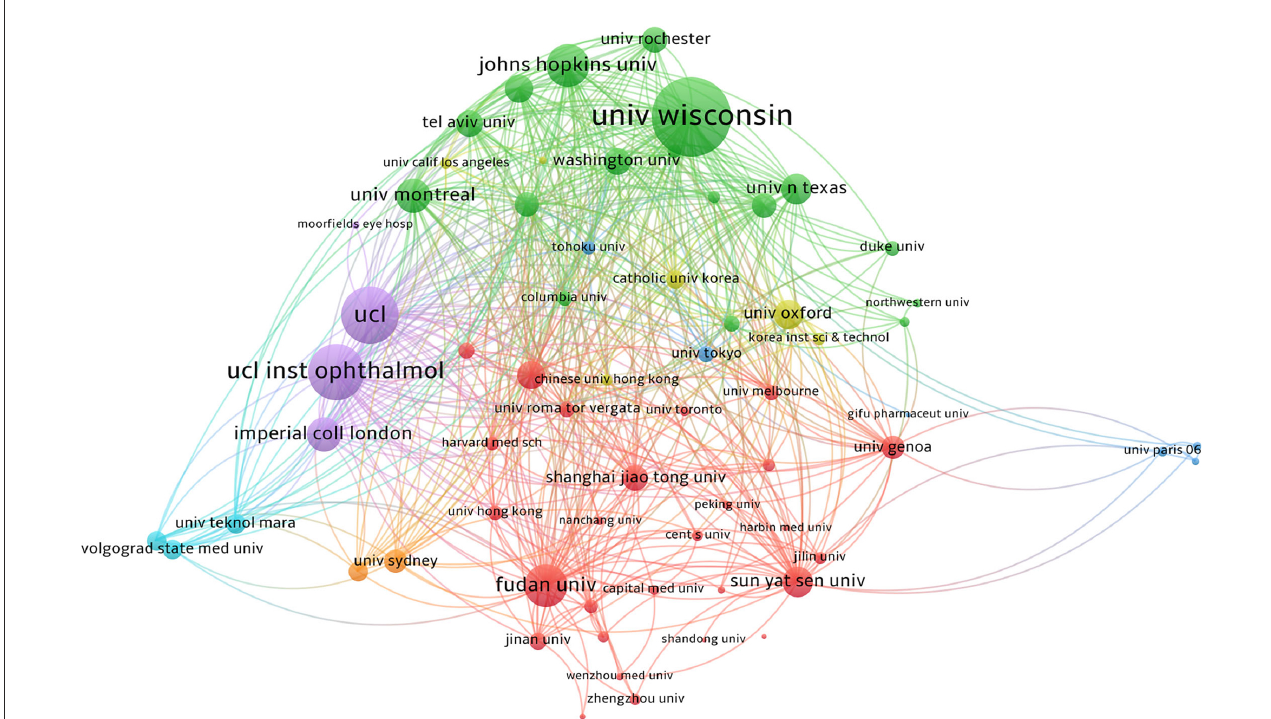
FIGURE4 A total of 1,538 institutions participated in the study of apoptosis in glaucoma. The network of co-authors was divided into seven clusters of different colors. The green cluster is dominated by American institutions, and the University of Wisconsin had the greatest impact. The red cluster is dominated by Chinese institutions.